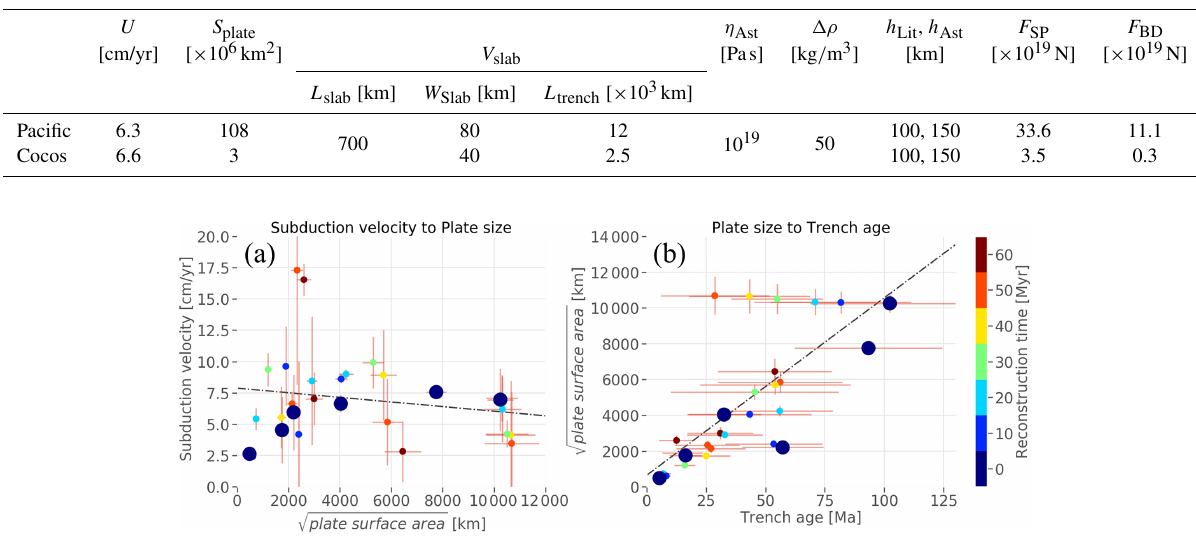
Figure 8. (a) Velocity of subducting plates from Müller et al. (2016) in lower-mantle (plume) reference frame (O’Neill et al., 2005) through- out the Cenozoic, as a function of characteristic plate size (measured as the square root of plate surface area). (b) Plate size as a function of age at the trench for subducting plates throughout the Cenozoic. Maps showing the subduction zones included at each time can be found in Fig. S3-1. Blue bold circles represent data from present-day subducting plates. Linear regression fits (black lines) show that there is no resolvable trend of velocity with plate size ( p value 0.351, R 2 0.03), while there is a trend of size with age ( p value < 0.05 and R 2 of